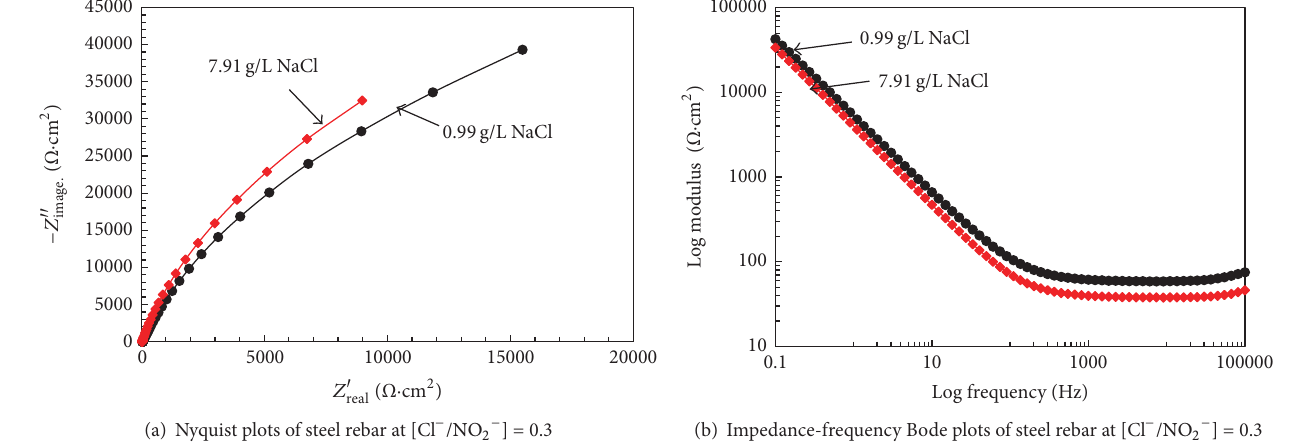
(a) Nyquist plots of steel rebar at [Cl − / NO 2− ] = 0.3 (b) Impedance-frequency Bode plots of steel rebar at [Cl − / NO 2− ] = 0.3